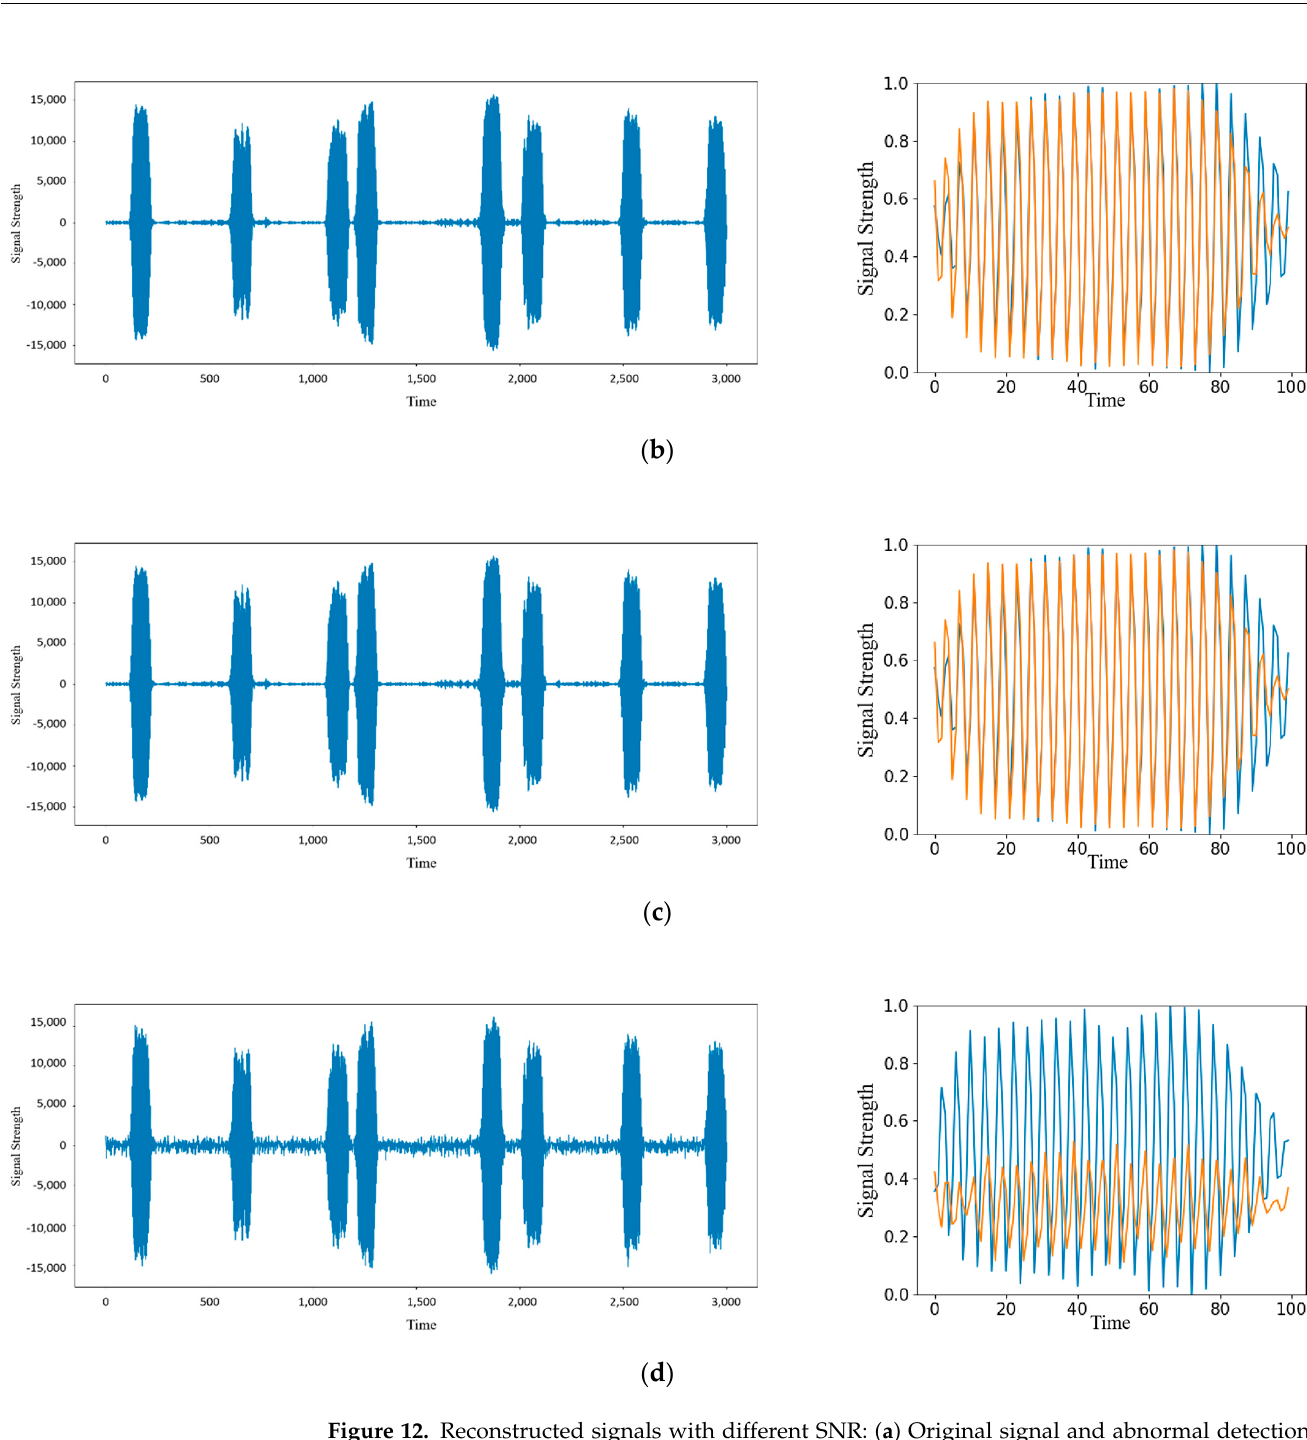
Figure 12. Reconstructed signals with different SNR: ( a ) Original signal and abnormal detection results; ( b ) Signal with SNR = 90 dB and its anomaly detection results; ( c ) Signal with SNR = 60 dB and its anomaly detection results; ( d ) Signal with SNR = 30 dB and its anomaly detection results.